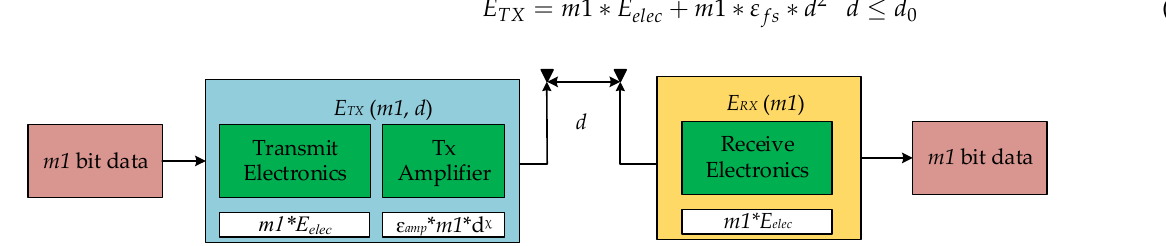
Figure 2. Radio energy consumption model.